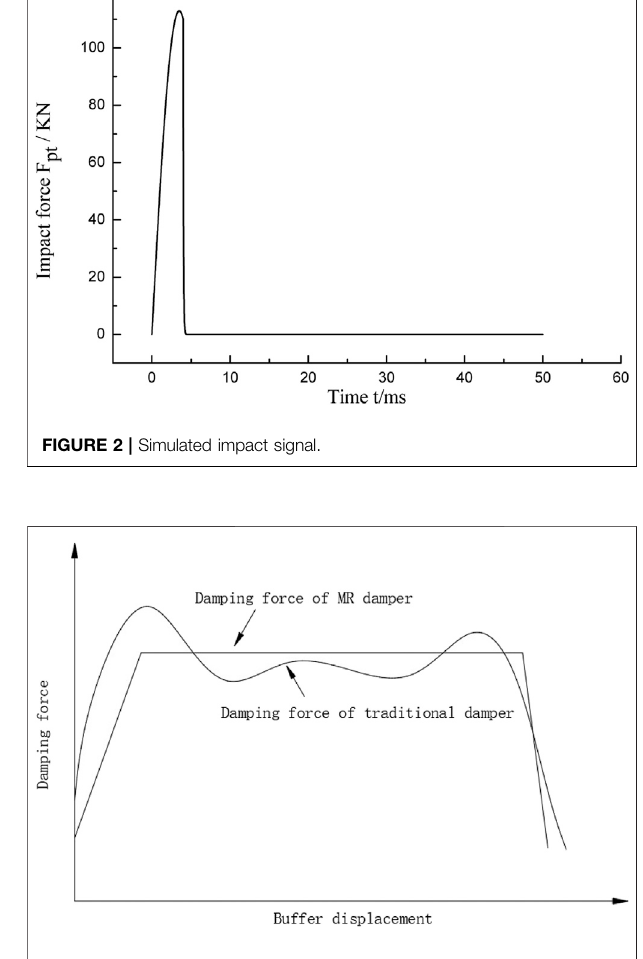
FIGURE 3 | Curve of control